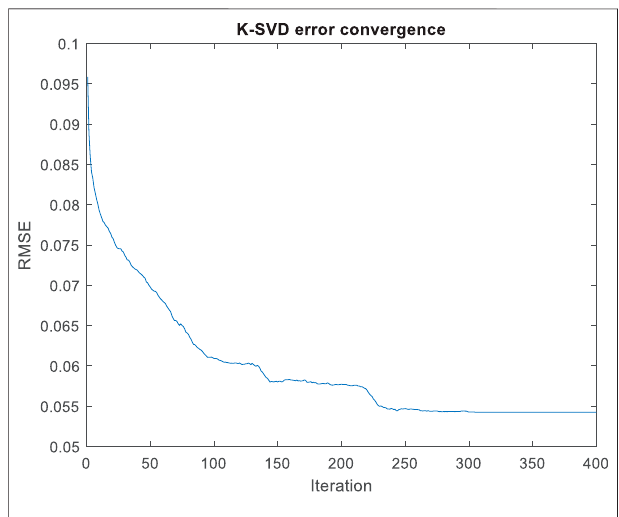
FIGURE 9 | Unstable dataset K-SVD